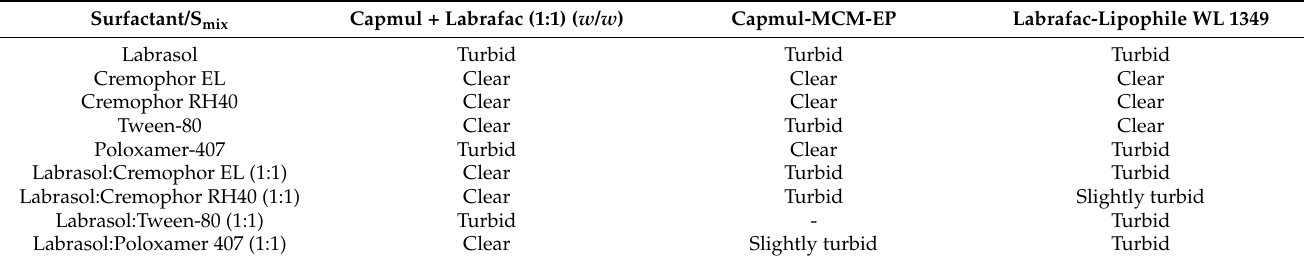
Table 1. Screening of oily phases with different surfactants (SAAs) and surfactant mixtures (S mixs ) based on visual